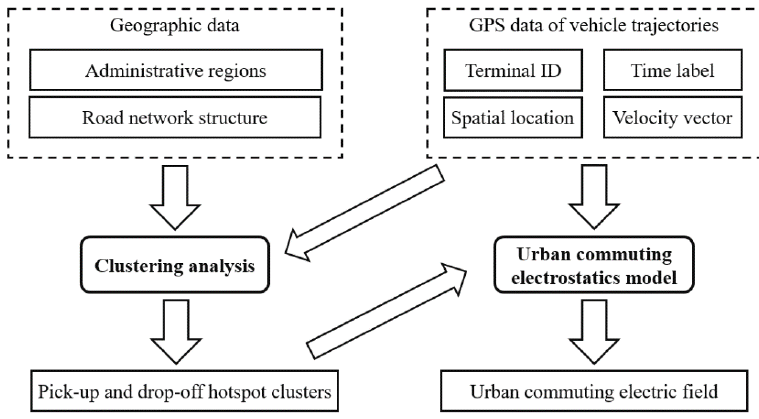
Figure 1. The structure of the method design in this paper.